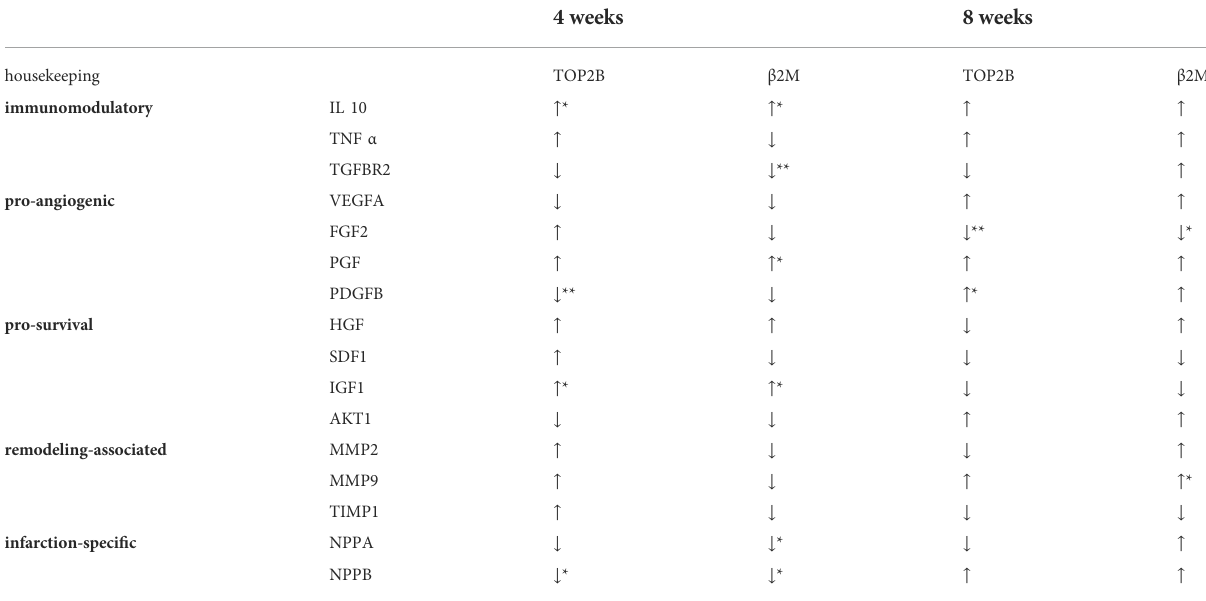
TABLE 2 Relative changes in gene expression of the anterior left ventricular myocardial wall after ventricular stabilization via TEMS-implantation following myocardial infarction. Gene group relative changes in gene expression* 4 weeks 8